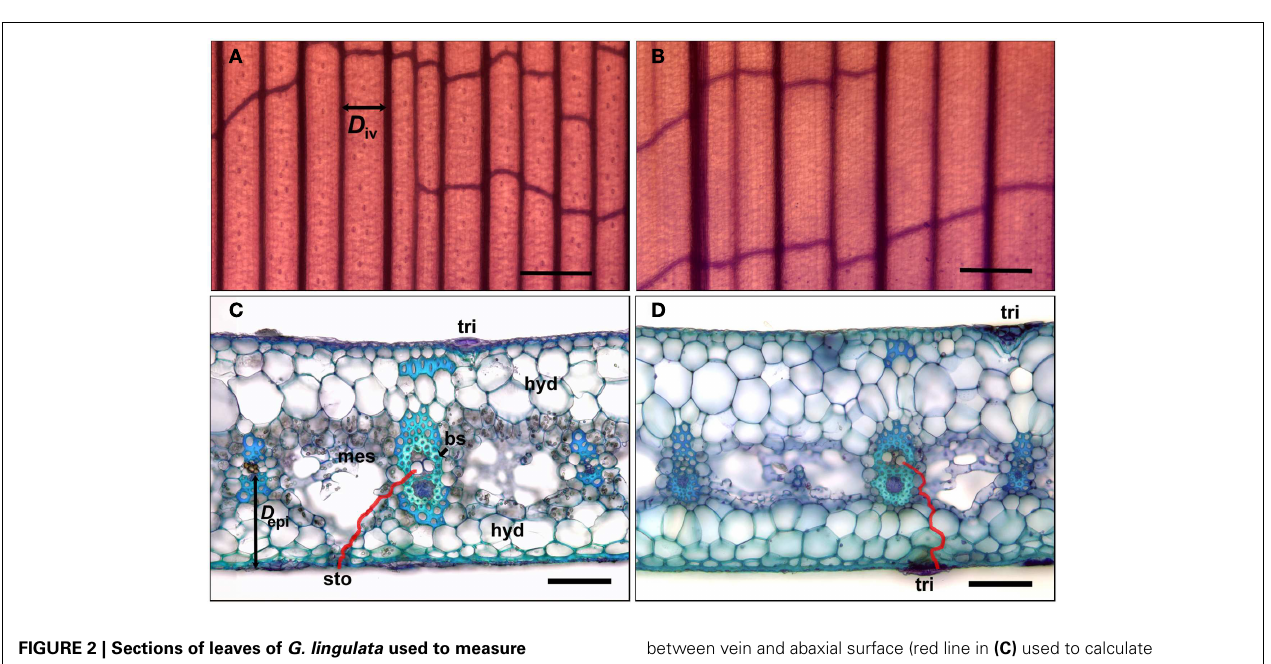
FIGURE 2 | Sections of leaves of G. lingulata used to measure anatomical traits. Leaf clearings of the leaf blade (A) and tank region (B) used to determine interveinal distance ( D iv ; black arrow); scale bars in (A) and (B) = 500 µ m. Cross-sections of the leaf blade (C) and tank region (D) ; red lines indicate pathways for water